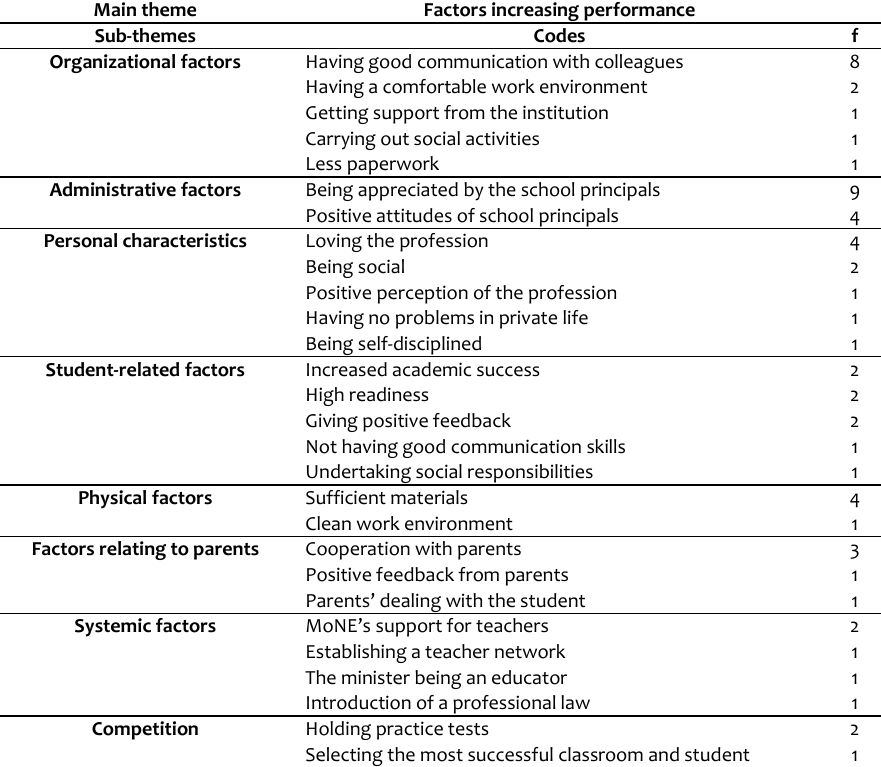
Table 5. Factors increasing teacher